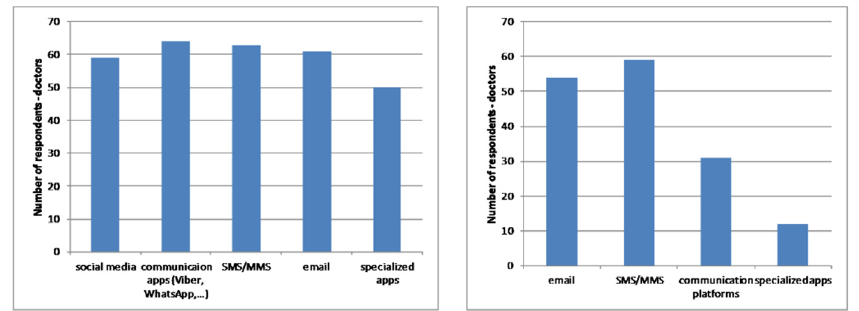
Figure 9. Frequency of doctors’ usage of mobile services ( left ) and affinity for mobile communication with pregnant women ( right ).